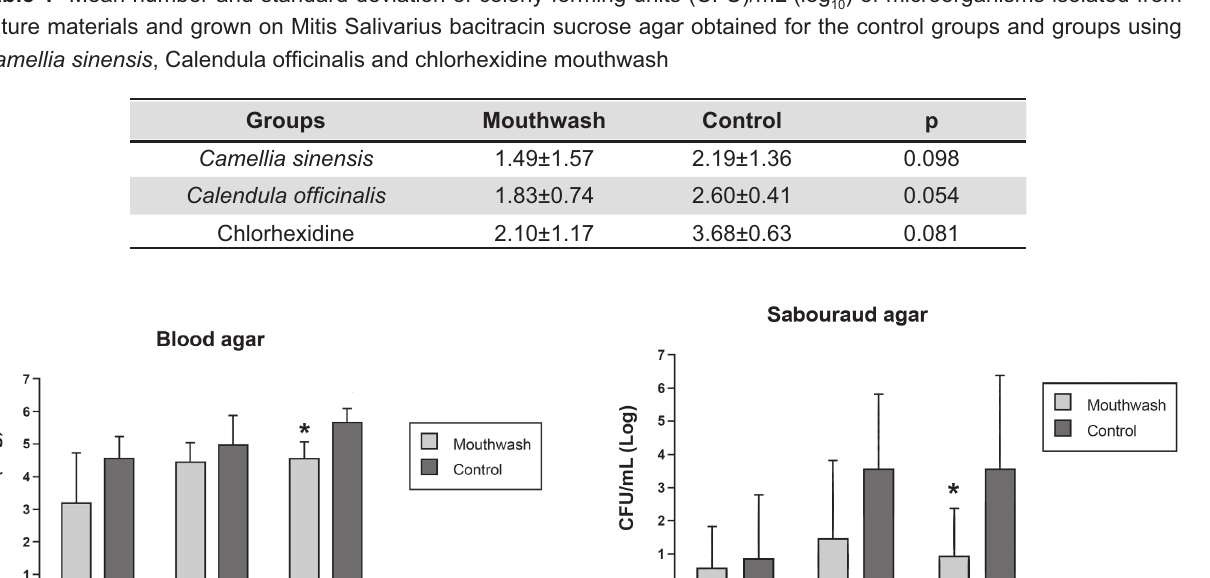
) of microorganisms isolated from 10